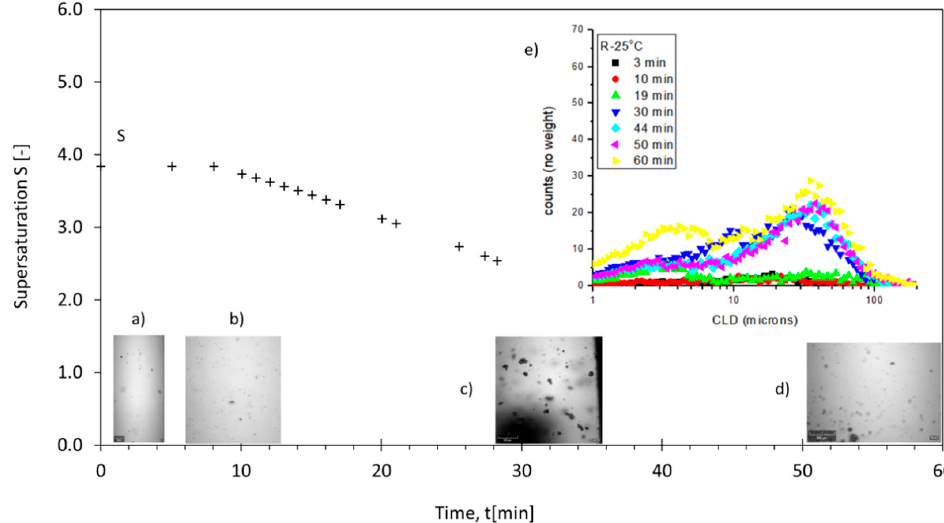
Figure 3. Supersaturation S , crystal/solution images and CLD for a reaction isotherm of 25 °C as a function of time at ( a ) 1.20 min, ( b ) 10 min, ( c ) 30 min, ( d ) 60 min, and ( e ) CLD.